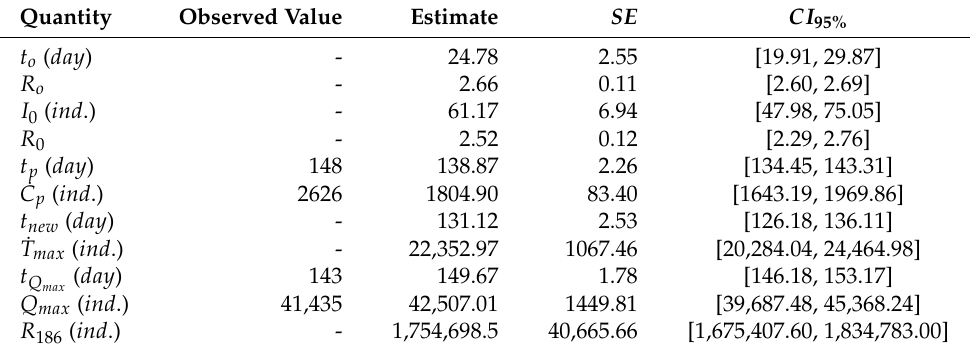
Table notes: t o , duration of the epidemic latency period; R o , basic reproduction number; I 0 , number of infectives at outbreak; R 0 , reproduction number at outbreak; t p , time of the peak of positive cases; ˙ C p , size of the peak of positive cases; t new , time of the peak of new infections; ˙ T max , size of the peak of new infections; t Q peak of active cases; Q max , size of the peak of active cases; R 186 , total number of recovered in the population at t = 186 days (i.e., at the end of the studied period (31 August 2020)); - indicates not